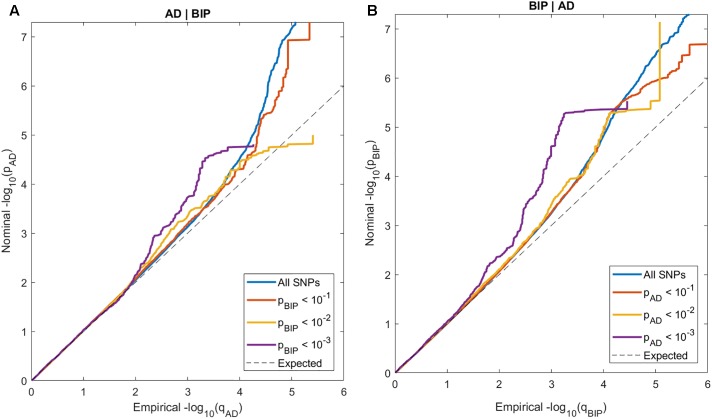
Conditional QQ-plots of nominal p-values at y-axis and 1 - empirical cumulative distribution function on x-axis for (A) Alzheimer’s disease (AD) with lines representing strata of SNPs according to their degree of association with bipolar disorder (BIP) and (B) BIP with lines representing strata of SNPs according to their degree of association with AD.